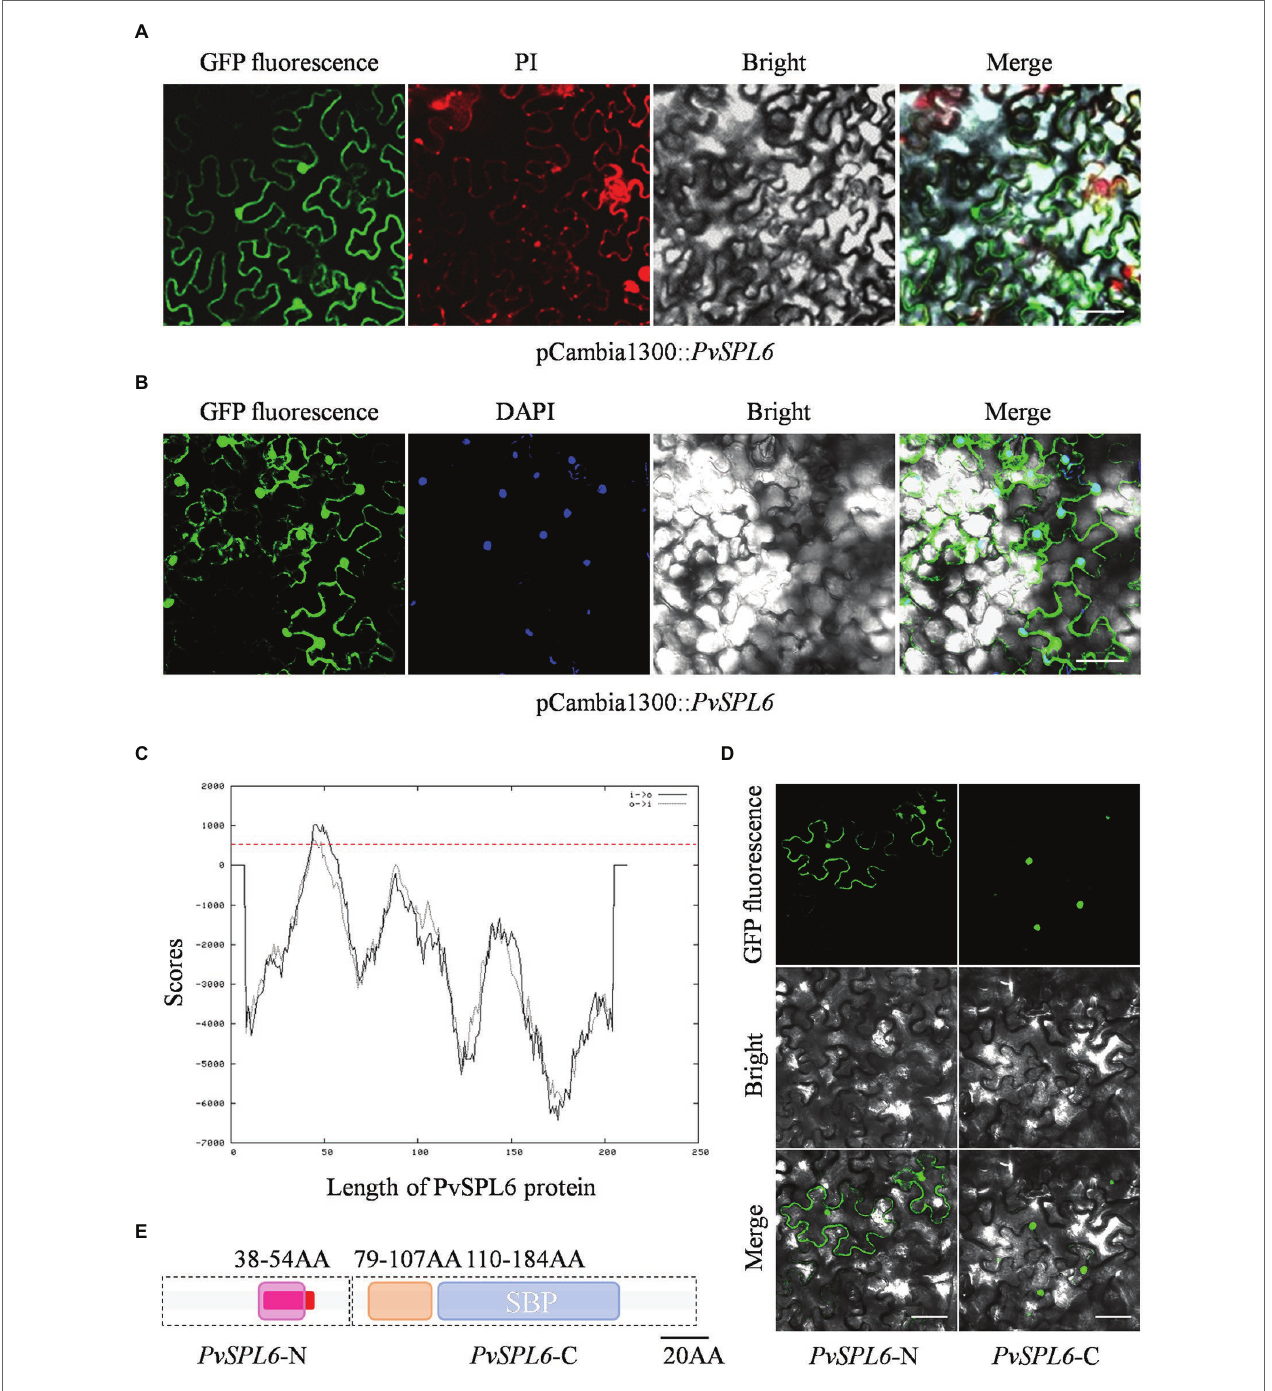
FIGURE 2 | Subcellular localization and bioinformatics analysis of PvSPL6. (A) and (B) Subcellular localization assays of PvSPL6. Agrobacterium cells harboring fusion constructs were infiltrated into the abaxial surfaces of Nicotiana benthamiana leaves, and samples were observed 72 h later under a GloMax 20/20 single tube luminometer (Promega, United States). GFP fluorescence, green fluorescent signal; PI, propidium iodide signal; DAPI, 4 ′ ,6-diamidino-2-phenylindole signal; Bright, bright field signal; and Merge, superimposed signal. Scale bar = 20 μ m. (C) Transmembrane domain prediction of PvSPL6 by TMPred. The red dotted line indicates a score of 500 (scores above 500 are considered significant). Black solid line means inside to outside helices; black dotted line means outside to inside helices. (D) Subcellular localization assays of PvSPL6-N and PvSPL6-C. GFP fluorescence, green fluorescent signal; Bright, bright field signal; and Merge, superimposed signal. Scale bar = 20 μ m. (E) Functional domain predictions of PvSPL6. The boxes indicate functional domains. Purple box means the first functional domain with low compositional complexity; orange box means the second functional domain with low compositional complexity; and blue box means conserved SBP domain. The red section indicates the predicted transmembrane